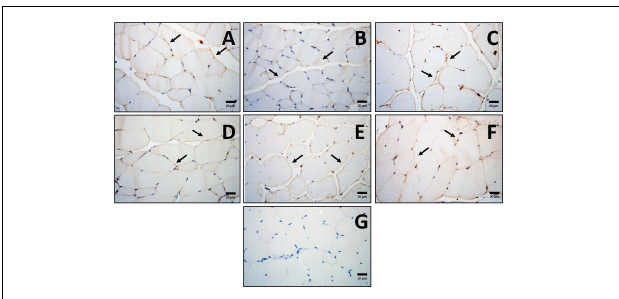
FIGURE 4 | Localization of muscle adiponectin. Representative cross-sections of quadriceps muscle with adiponectin immunohistochemistry determined by immunoperoxidase stain, and nuclear counter-staining with haematoxylin. CHOW untrained (A) , CHOW+END (B) , CHOW+HIIT (C) , HFD untrained (D) , HFD+END (E) , and HFD+HIIT (F) are displayed. No striking differences were seen across the different groups. Positive staining was mainly found in the sarcolemma followed by a less intense signal in the cytoplasmic region as indicated by arrows. A negative control without primary antibody is shown in (G) . The size bars indicate 20 µ m and images are at 40 ×